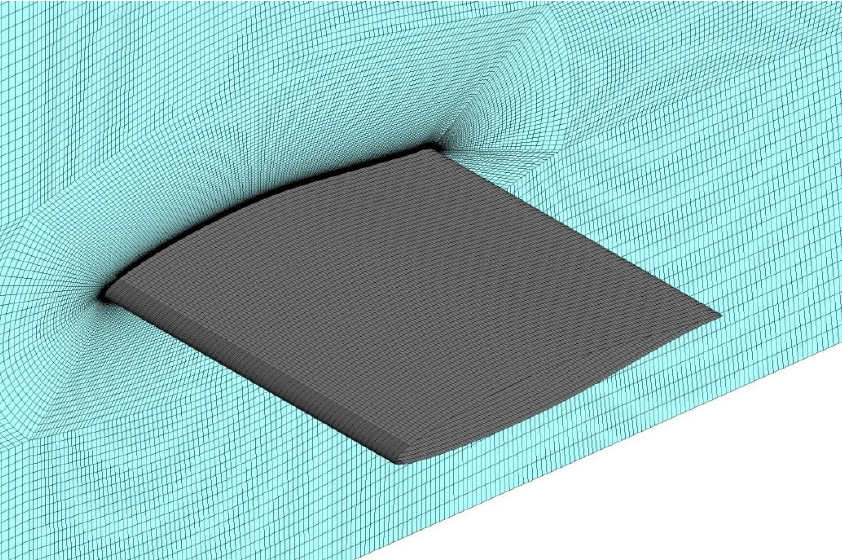
Figure 2. Mesh distribution.